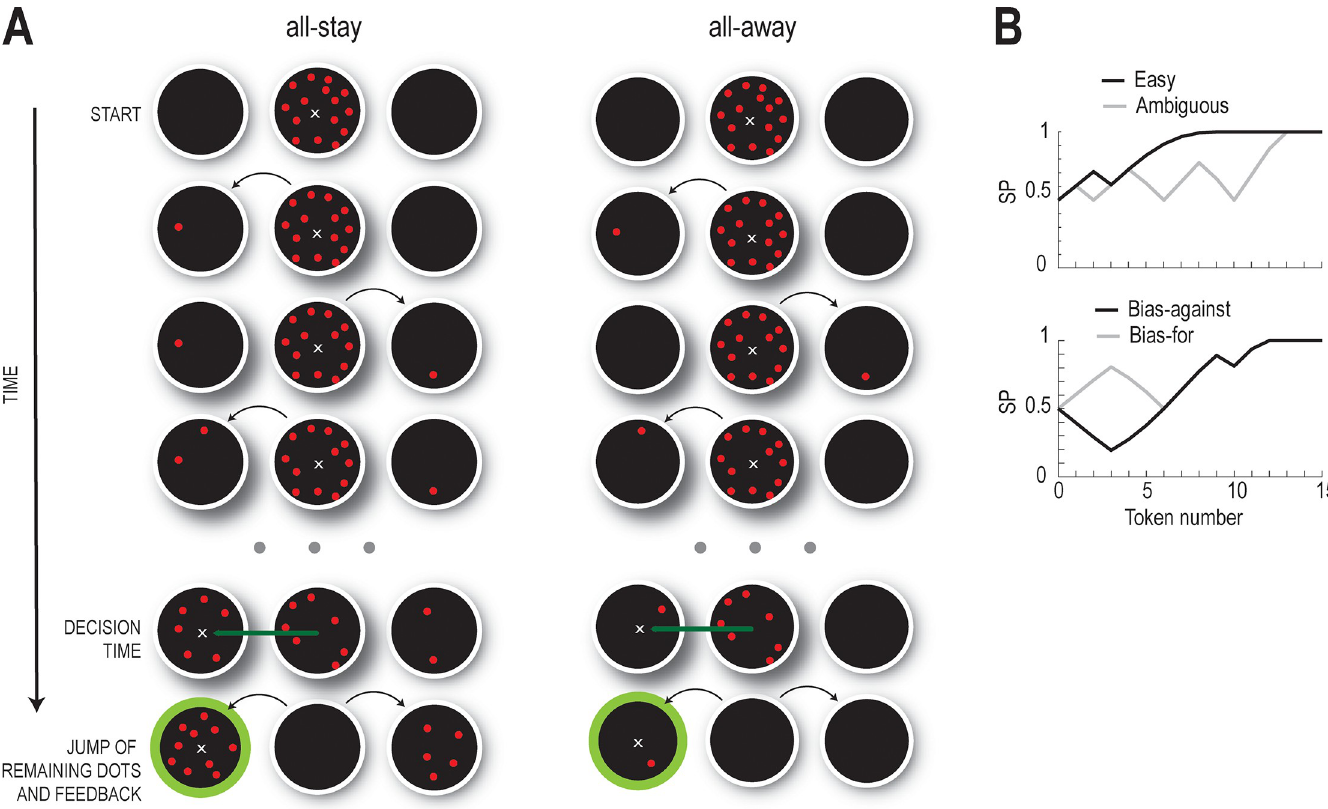
Fig 1. Experimental design. (A) Temporal presentation of events during a trial. Each trial starts with all the tokens in the central circle. After the participant moves the cursor to inside the central circle, the tokens start jumping successively to the other two (target) circles. In the all-stay trials the tokens remain visible after jumping, while in the all-away trials they disappear soon after they have jumped. The participant has to guess which of the two target circles will contain more tokens at the end of the trial. (B) Success probability profiles for specific trial types. Top panel , success probability for easy (black) and ambiguous (gray) trials. Bottom panel , success probability for bias-against (black) and bias-for (gray)